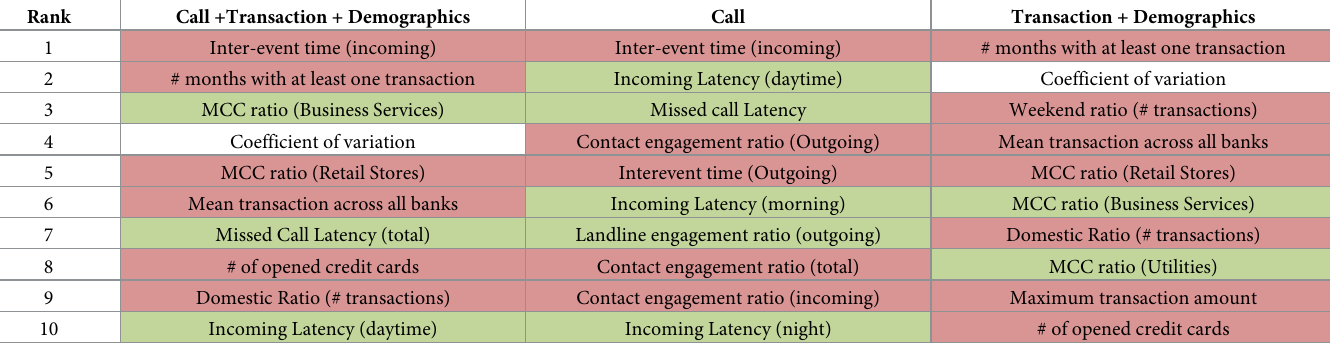
Table 10. Top-10 features for each category, as well as the sign (positive or negative) of their Pearson’s correlation with the outcome variable (having financial trou- ble or not).